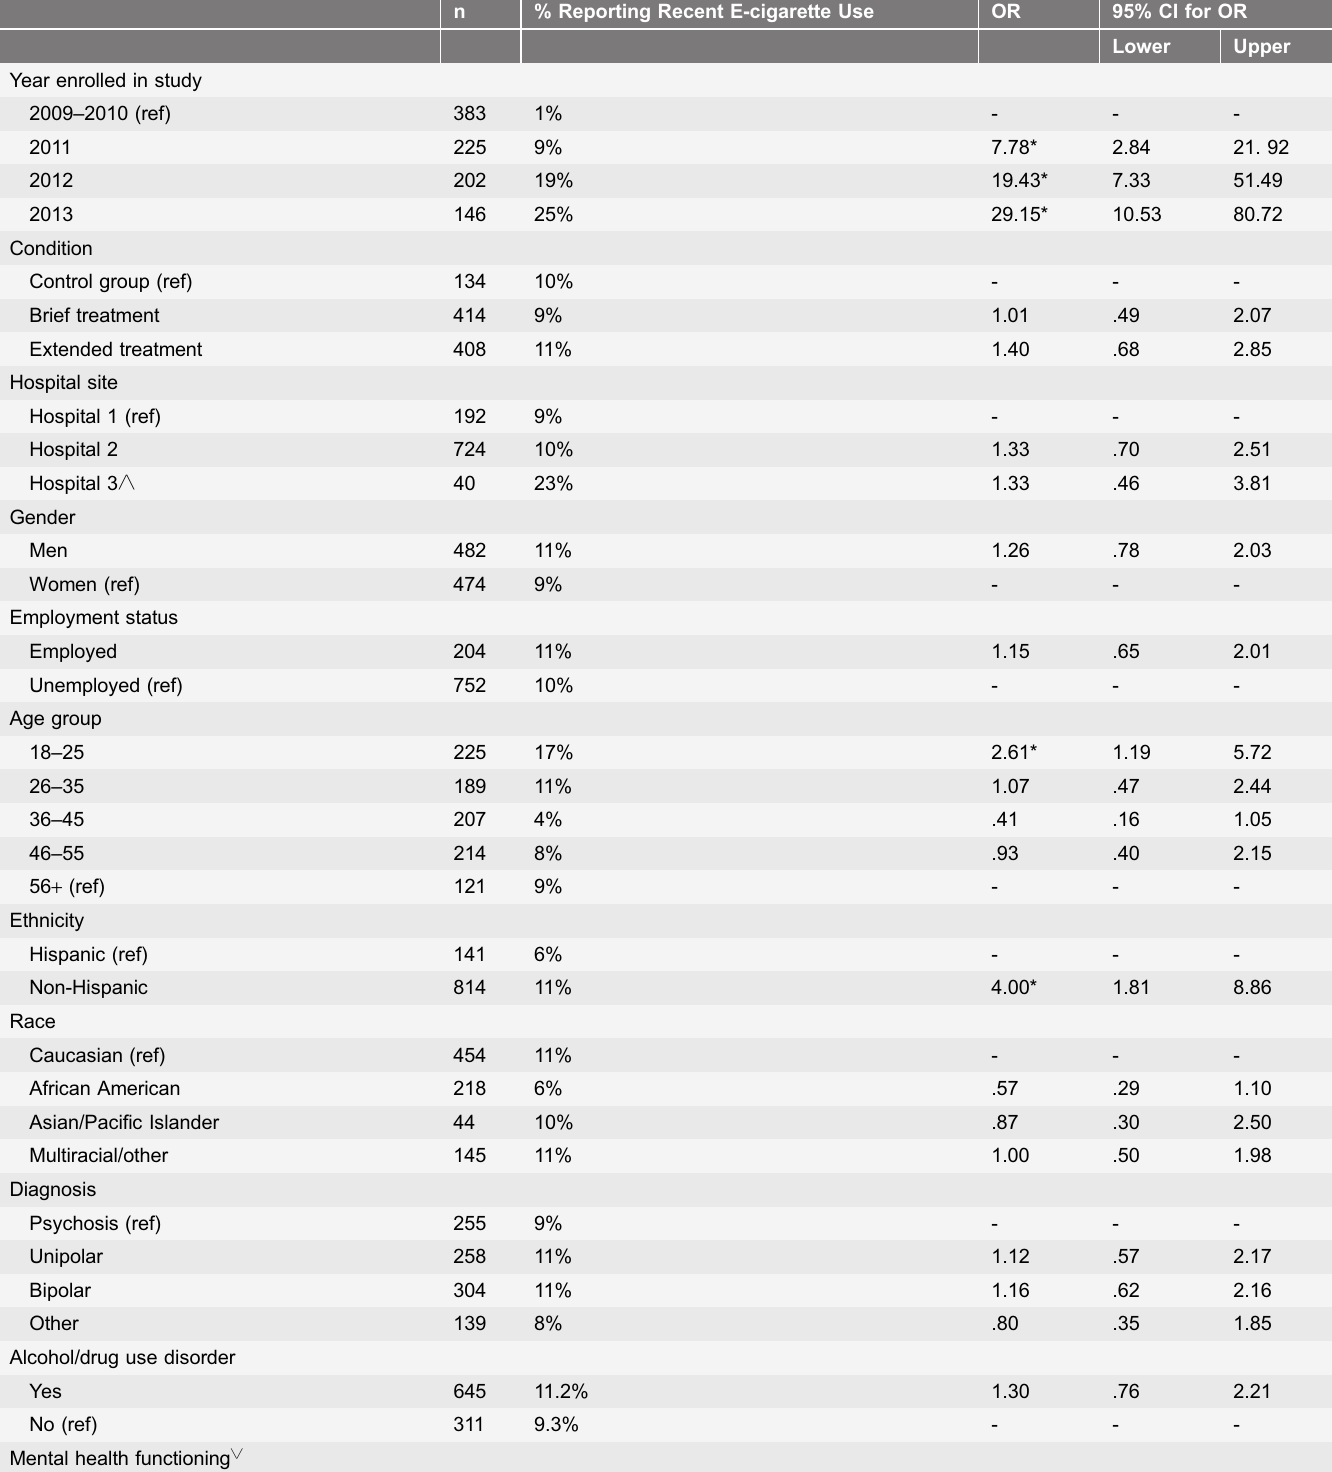
Table 1. Descriptive Characteristics and Multiple Logistic Regression Model Testing Study-level, Demographic, Psychiatric, and Tobacco-Related Variables Associated with E-Cigarette